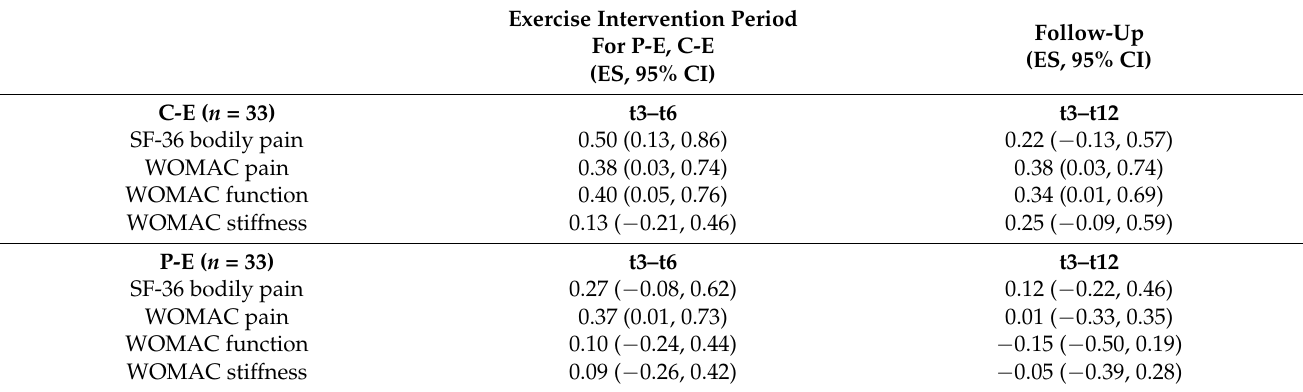
Table 3. Effect sizes (Hedges g z [26]) and 95% CIs for clinical outcome measures ( n = 115) in the voluntary exercise intervention period (t3–t6) considering t3 as baseline (P-E and C-E).